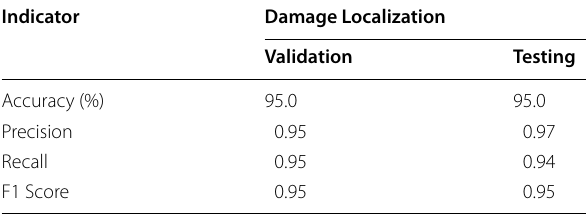
Table 4 Performance indicators calculated from the classification of CWT images of close and far damage Indicator Damage Localization